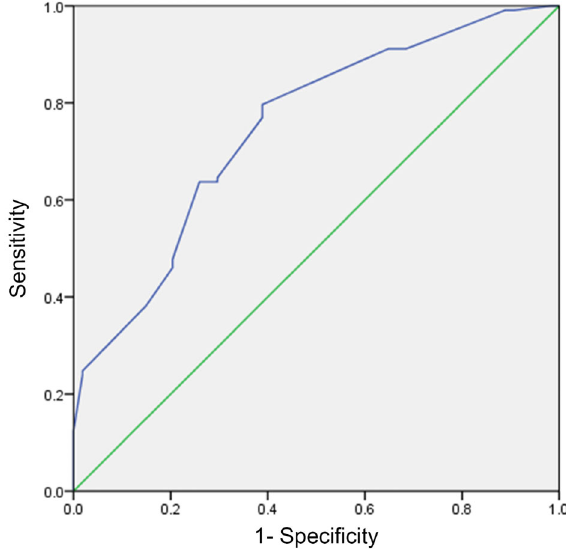
Figure 2. Receiver operating characteristic (ROC) curve analysis of carotid artery intima-media thickness (CIMT) for predicting lower limb peripheral arterial disease. The area under the curve was 0.747 (P o 0.001), and calculation of the Youden index revealed that the optimal cutoff value for CIMT was 0.71 mm. Table 2. Univariate logistic regression analysis of factors associated with peripheral arterial